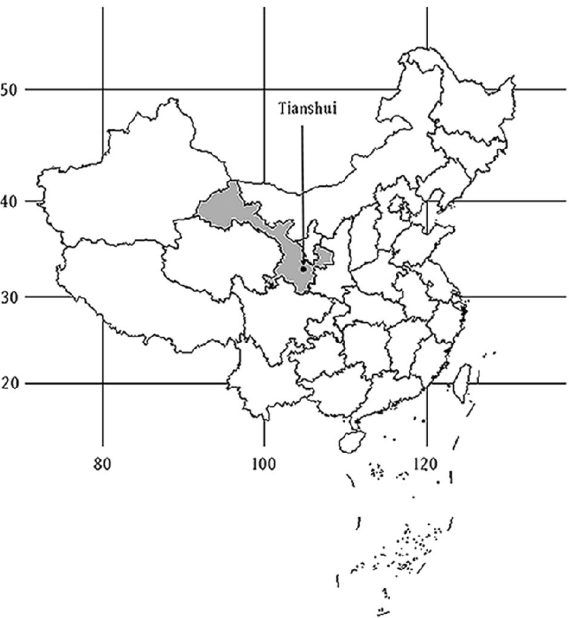
Figure 1. Geographical location of Tianshui, China.